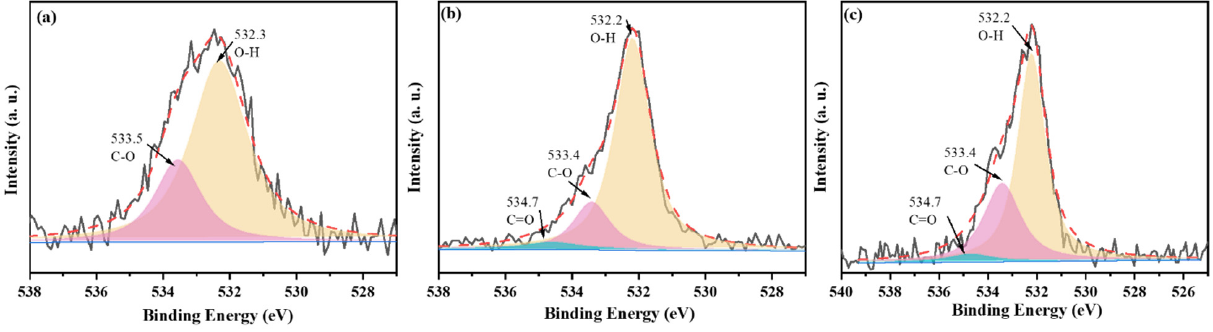
Figure 12. High-resolution O 1s spectra in CSPAC ( a ) before and ( b ) after the reaction in the Fe 3+ /CSPAC/H 2 O 2 system, and ( c ) after the reaction in the Fe 3+ /CSPAC system.